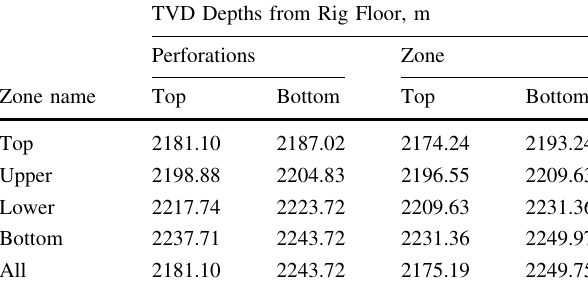
Table 2 Invariant simulation data